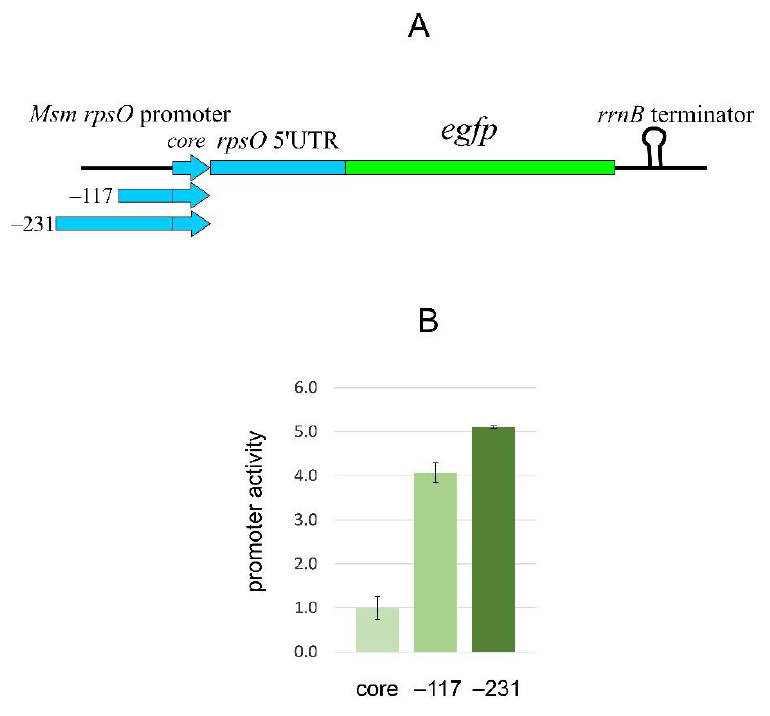
Figure 5. The expression level of the chromosomally integrated Msm rpsO-egfp reporter depends on the 5 (cid:48) -extension of the Msm rpsO promoter. ( A ) Msm rpsO-egfp reporters with different 5 (cid:48) extensions within the Msm chromosome. ( B ) Results of fluorescent measurements of protein lysates obtained from exponential Msm cells bearing rpsO-egfp reporters governed by the rpsO promoters with different 5 (cid:48) extensions; positions of relative TSS are indicated, with “core” corresponding to the 5 (cid:48) edge position − 47. Fluorescence (average of at least three biological replicates) of the protein samples corresponding to the core promoter construct is taken as a